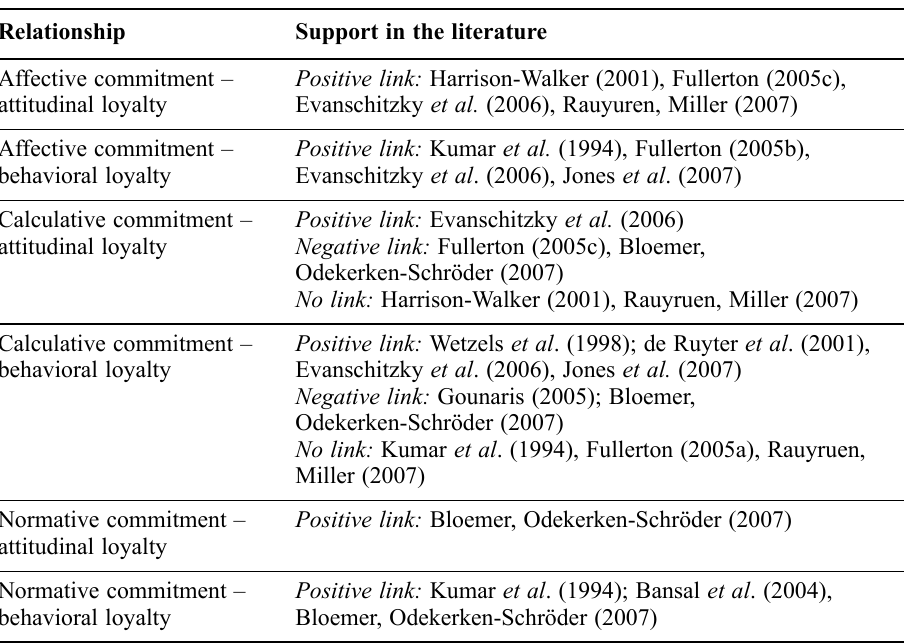
Table 1. Support for examined relationships between components of commitment and loyalty Relationship Support in the literature Affective commitment – attitudinal loyalty Affective commitment